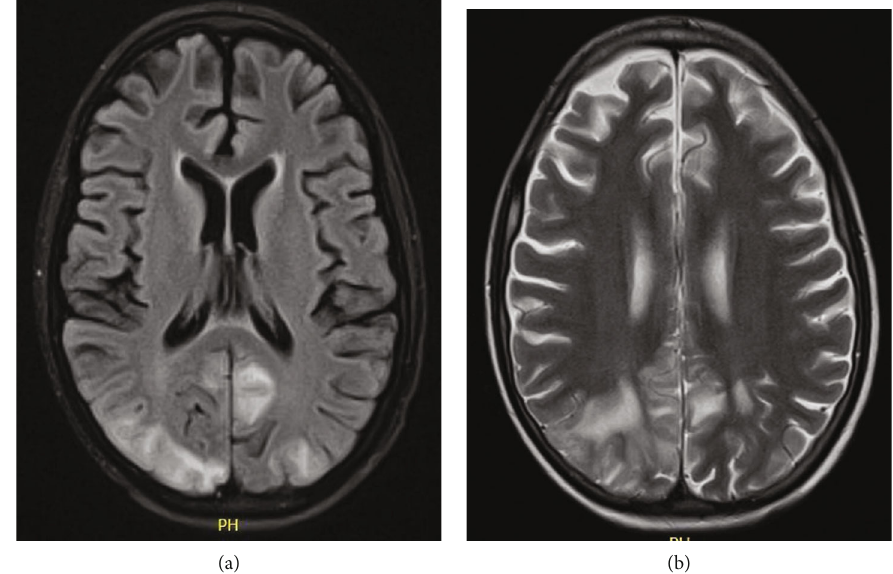
Figure 3: Brain MR of case 3. (a) Fluid-attenuated inversion recovery sequence showing occipitoparietal hyperintensities and (b) its representation in T2-weighted